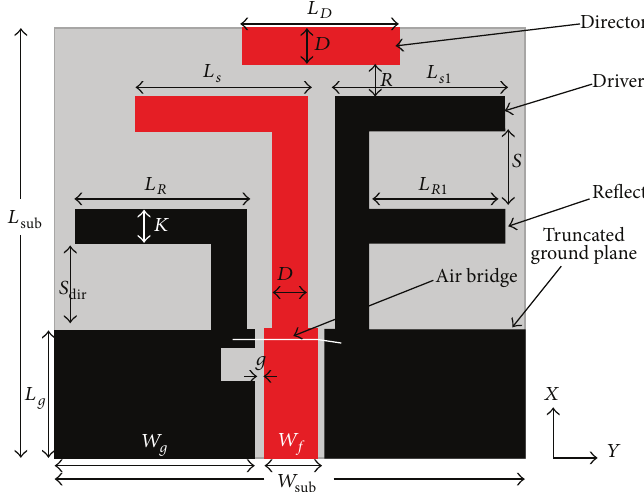
Figure 1: The proposed quasi-Yagi antenna configuration.